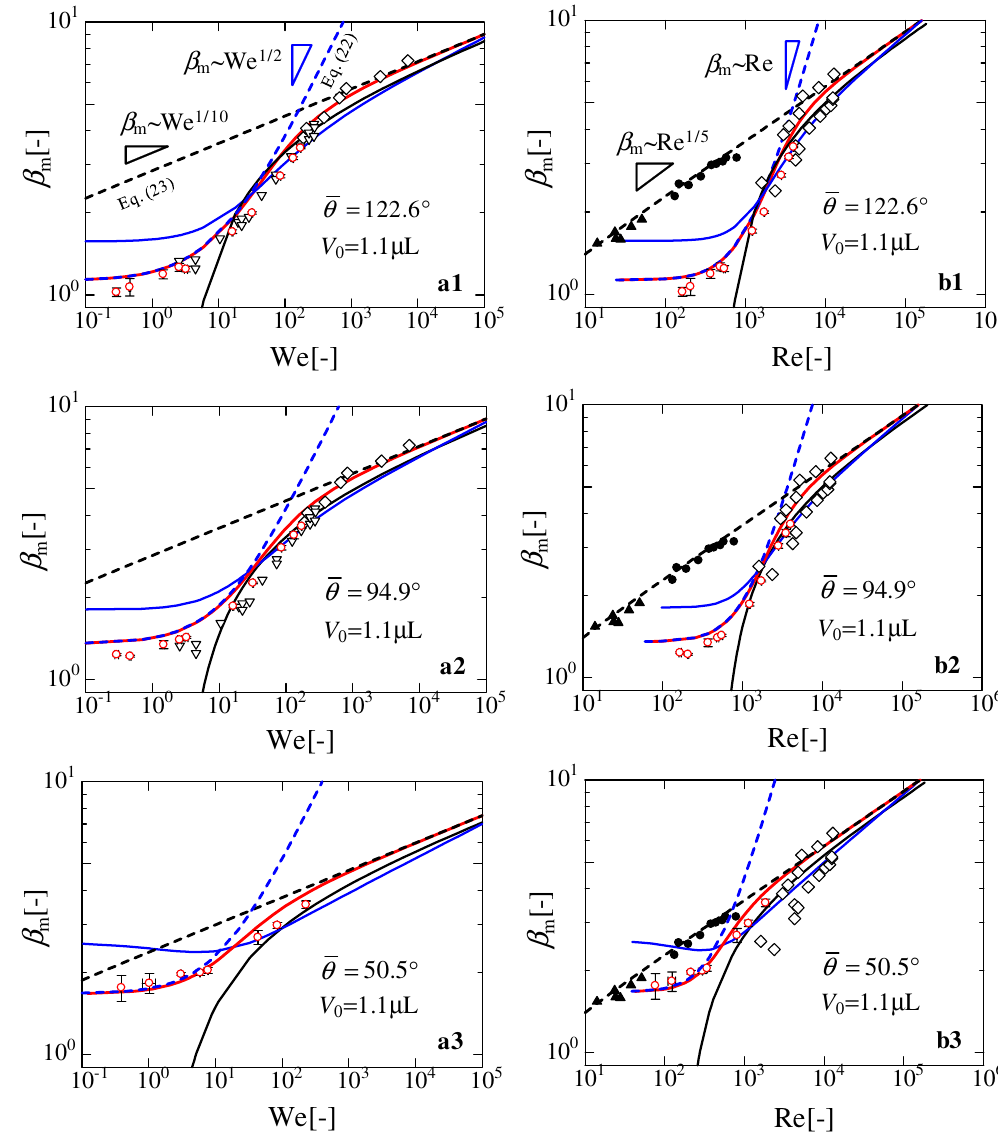
Figure 3. Relationships between β m and non-dimensional numbers. (a1,a2 and a3) Plots of β m versus We for purified water droplets on silicon rubber (SR) and on polycarbonate (PC), and ethanol on SR, respectively. (b1,b2 and b3) Plots of β m versus Re for purified water droplets on SR and on PC, and ethanol on SR, respectively. The black and blue solid lines in each figure correspond to analytical results calculated by Roisman’s 27 and Pasandideh-Fard et al .’s 10 model, respectively. The blue and black dashed lines are the limiting solutions of the capillary (Eq. (22)) and viscous (Eq. (23)) regimes obtained by the present model. Here, V 0 is the droplet volume and θ is the averaged contact angle of θ st and θ d . Red circles ( ⚬ ) represent the experimental data obtained in this study. White diamond ( ⬦ ) and inverted triangle ( ▿ ) markers represent water on an Al substrate and a superhydrophobic surface, respectively 17 . Black circle ( ⦁ ) and triangle ( ▴ ) markers represent existing experimental results for high-viscosity liquids (silicone oils) of μ = 20 mPa s and 300 mPa s, respectively 17